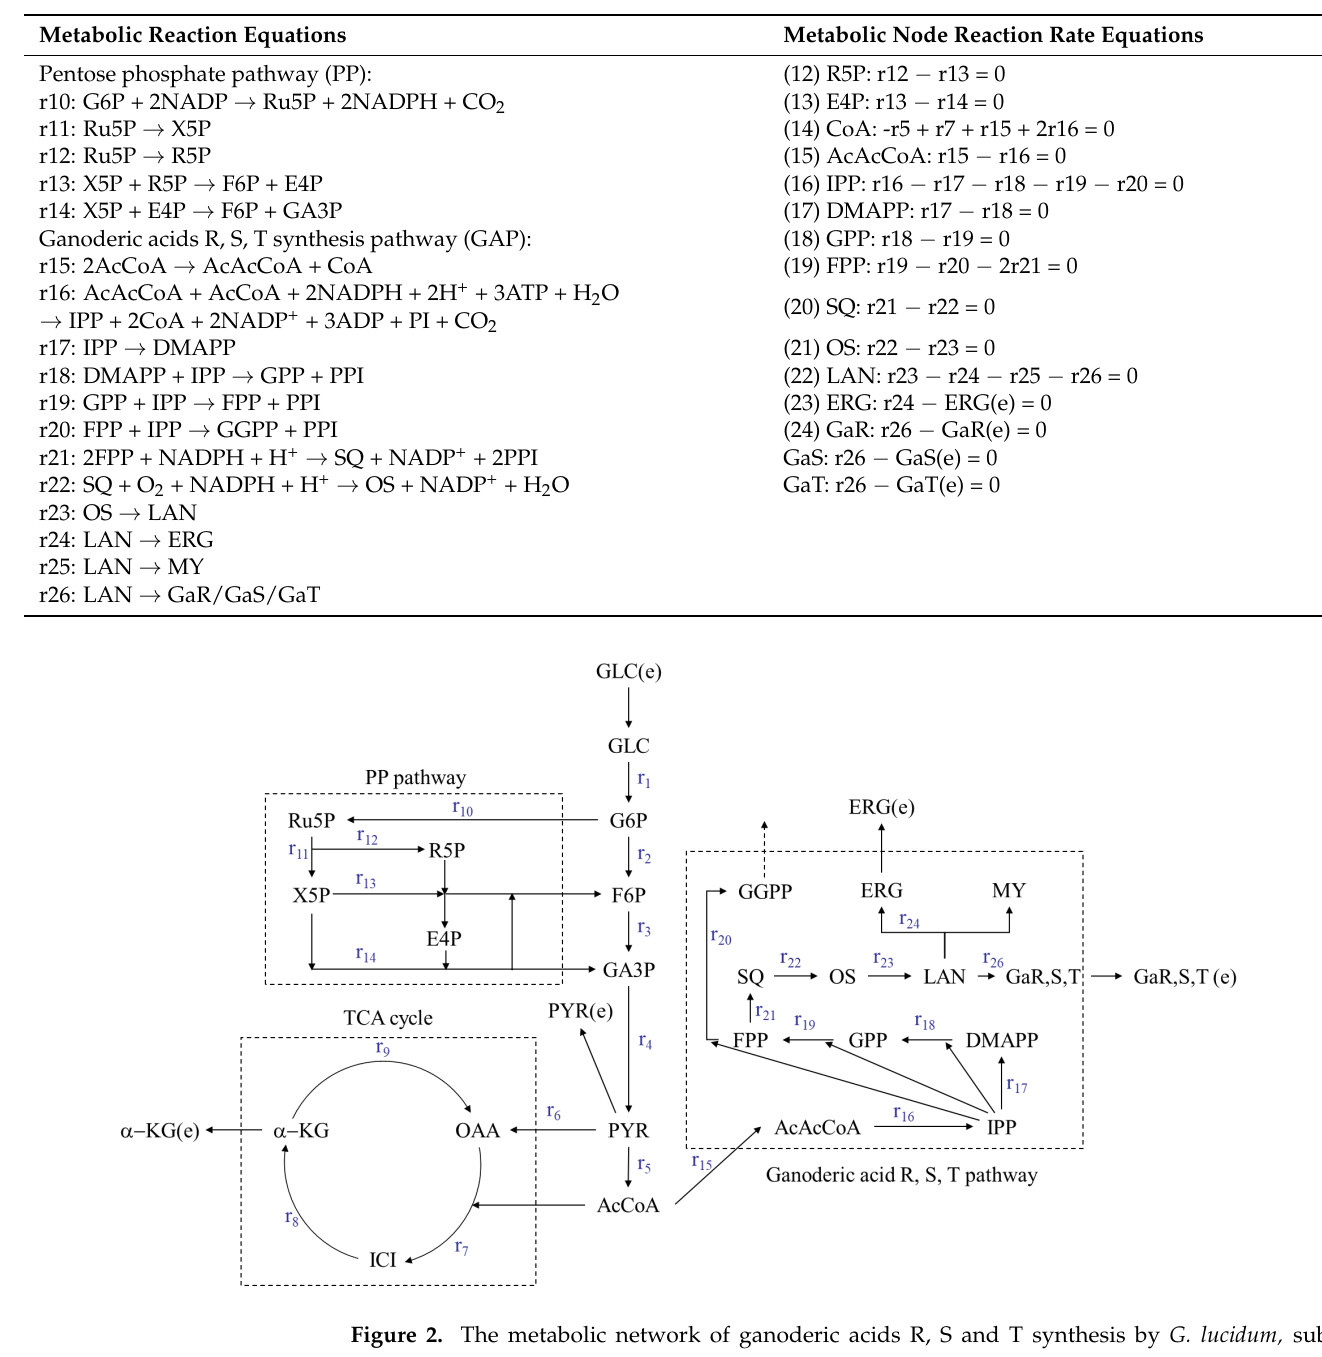
Table 1. Metabolic reaction equations and metabolic node reaction rate equations of ganoderic acids R, S and T ’s synthesis from submerged fermentation-static culture of G. lucidum.